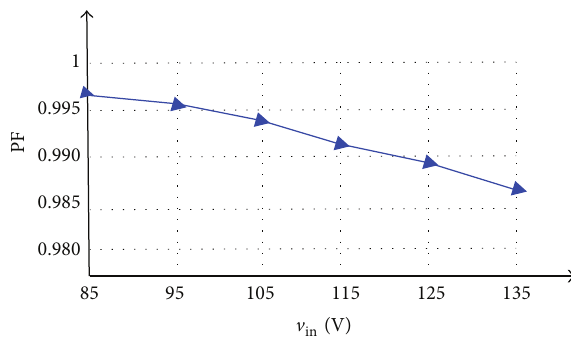
Figure 12: Measured PF value at full load of the proposed converter as the function of input